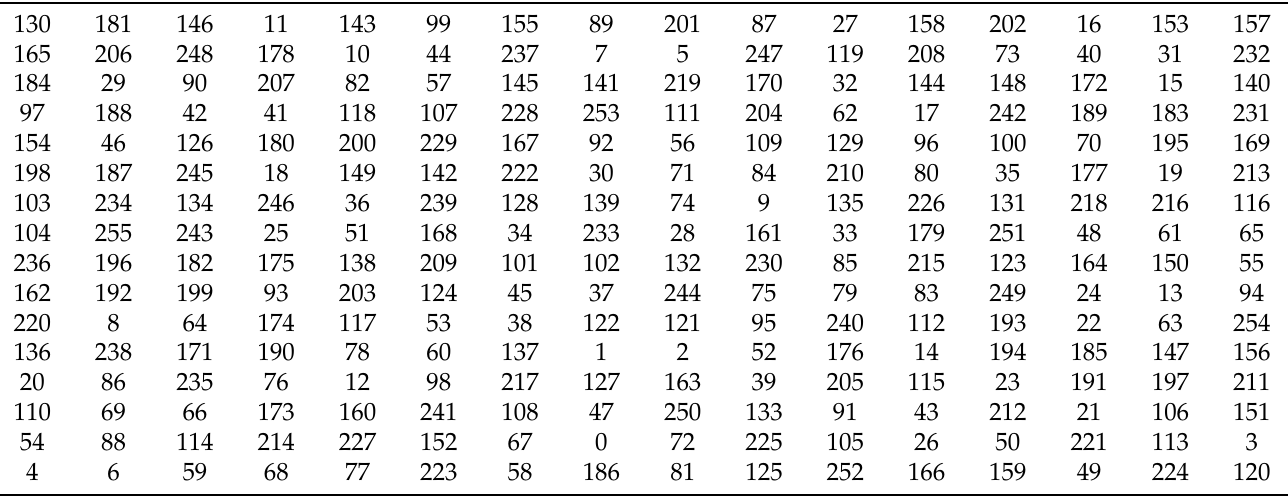
Table 2. S-box by the proposed scheme.